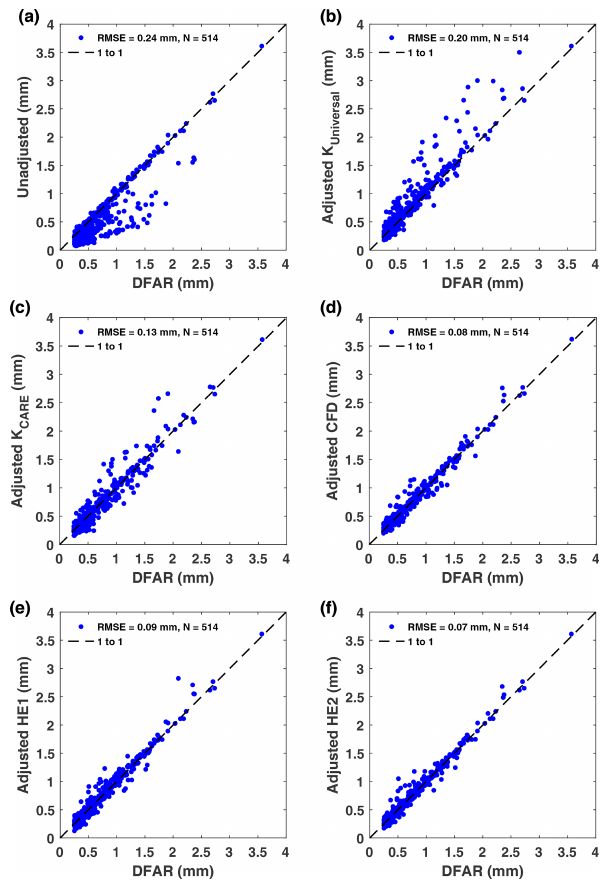
Figure 7. Unshielded and reference DFAR 30min event precipita- tion accumulation comparison for (a) unadjusted precipitation ac- cumulation, (b) K Universal continuous transfer function with wind speed and air temperature dependence, (c) K CARE continuous transfer function with wind speed and air temperature dependence, (d) CFD transfer function with wind speed and fall velocity depen- dence, (e) HE1 transfer function with wind speed and fall velocity dependence, and (f) HE2 transfer function with wind speed and fall velocity